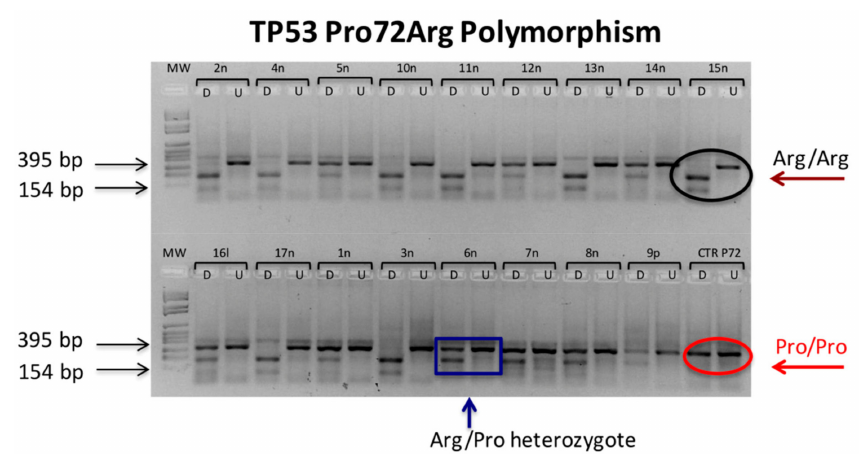
Figure 2. BstUI restriction fragment length polymorphism (RFLP) analysis of p53 codon 72 dimorphism. The presence of a guanosine at nucleotide 216 in the exon 4th amplicon can be revealed BstUI restriction. Thus, the presence of two 131 and 208 bp bands in digested lane (D) stands for the R72 variant (black circle) whereas the full length 339 bp undigested band indicates the P72 variant (red circle). Both digested and undigested bands in D lanes indicate Pro / Arg heterozygous (blue box). (U) Undigested